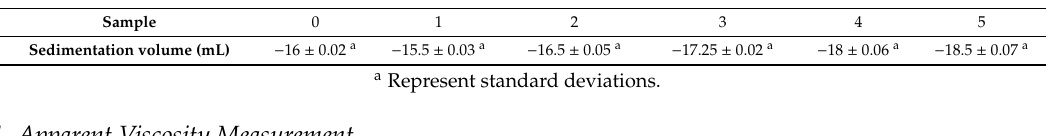
Table 2. The sedimentation volume of di ff erent adhesives: 0: HMP adhesive, 1: WF adhesive,